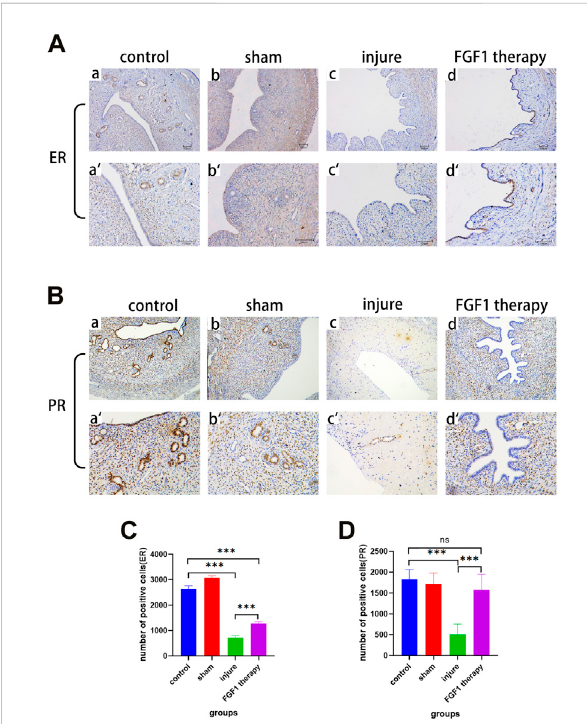
FIGURE 4 FGF1 increases ER and PR expression in the endometrium and restoresuterinefunction.TheresultsofERexpressionbyusingIHC.a- d 100X, a ’– d ’ 200X (A) . The results of PR expression by using IHC. a-d 100X, a ’– d ’ 200X (B) . Analysis of ER IHC results, the number of positive cells expressing ER. n = 7, *** p < 0.001 (C) . Analysis of PR IHC results, the number of positive cells expressing PR. n = 6, ns > 0.05, *** p < 0.001 (D) .